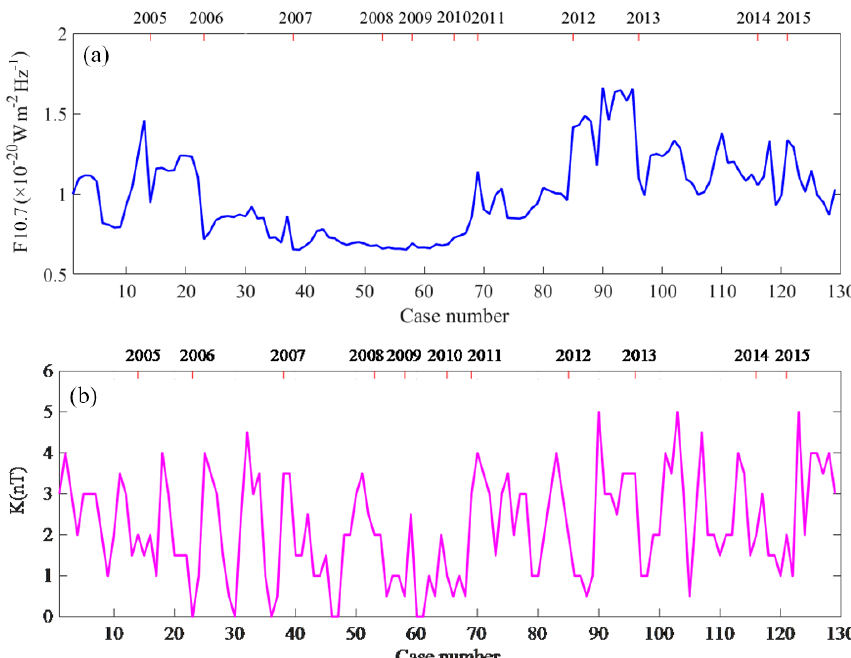
Figure 8. (a) The variations of F10.7 values corresponding to the occurrence of PMSEs with the axis at the top showing the time in years. (b) The variations of geomagnetic K-index values corresponding to the occurrence of PMSEs with the axis at the top showing the time in